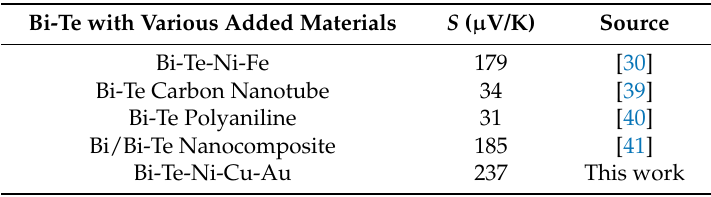
Table 4. Comparison on the absolute value of Seebeck coefficient, S